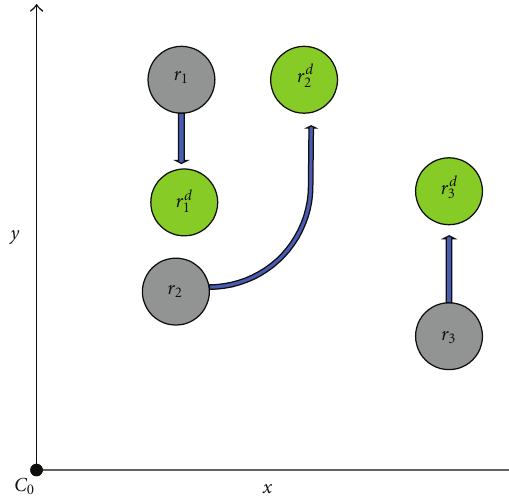
Figure 3: The framework for P3 mobile robot team with virtual